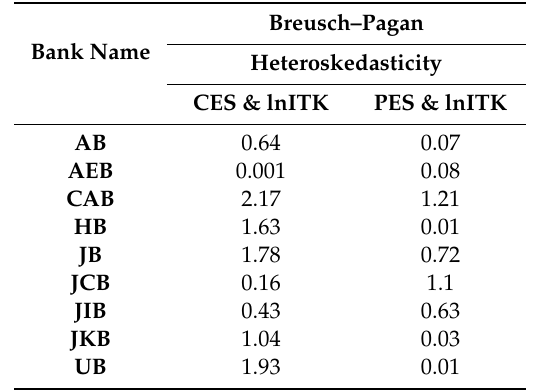
Table A3. Test for Heteroskedasticity using Breusch-Pagan test. Bank